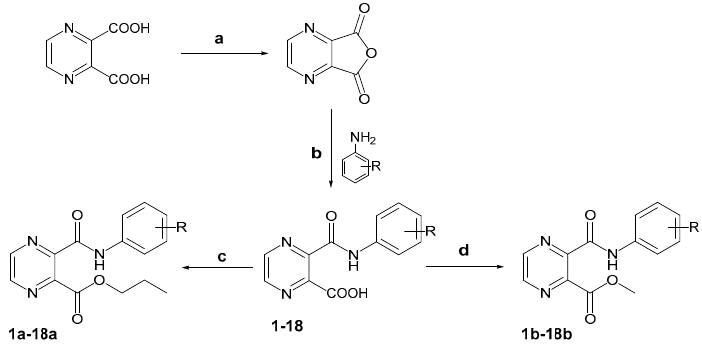
Scheme 1. Synthetic procedures of prepared series. Reagents and Conditions: ( a ) acetic anhydride, reflux, 1 h; ( b ) 1. tetrahydrofuran, RT, 1 h, 2. water, NaHCO 3 sol.; ( c ) propanol, H 2 SO 4 , MW: 120 °C,